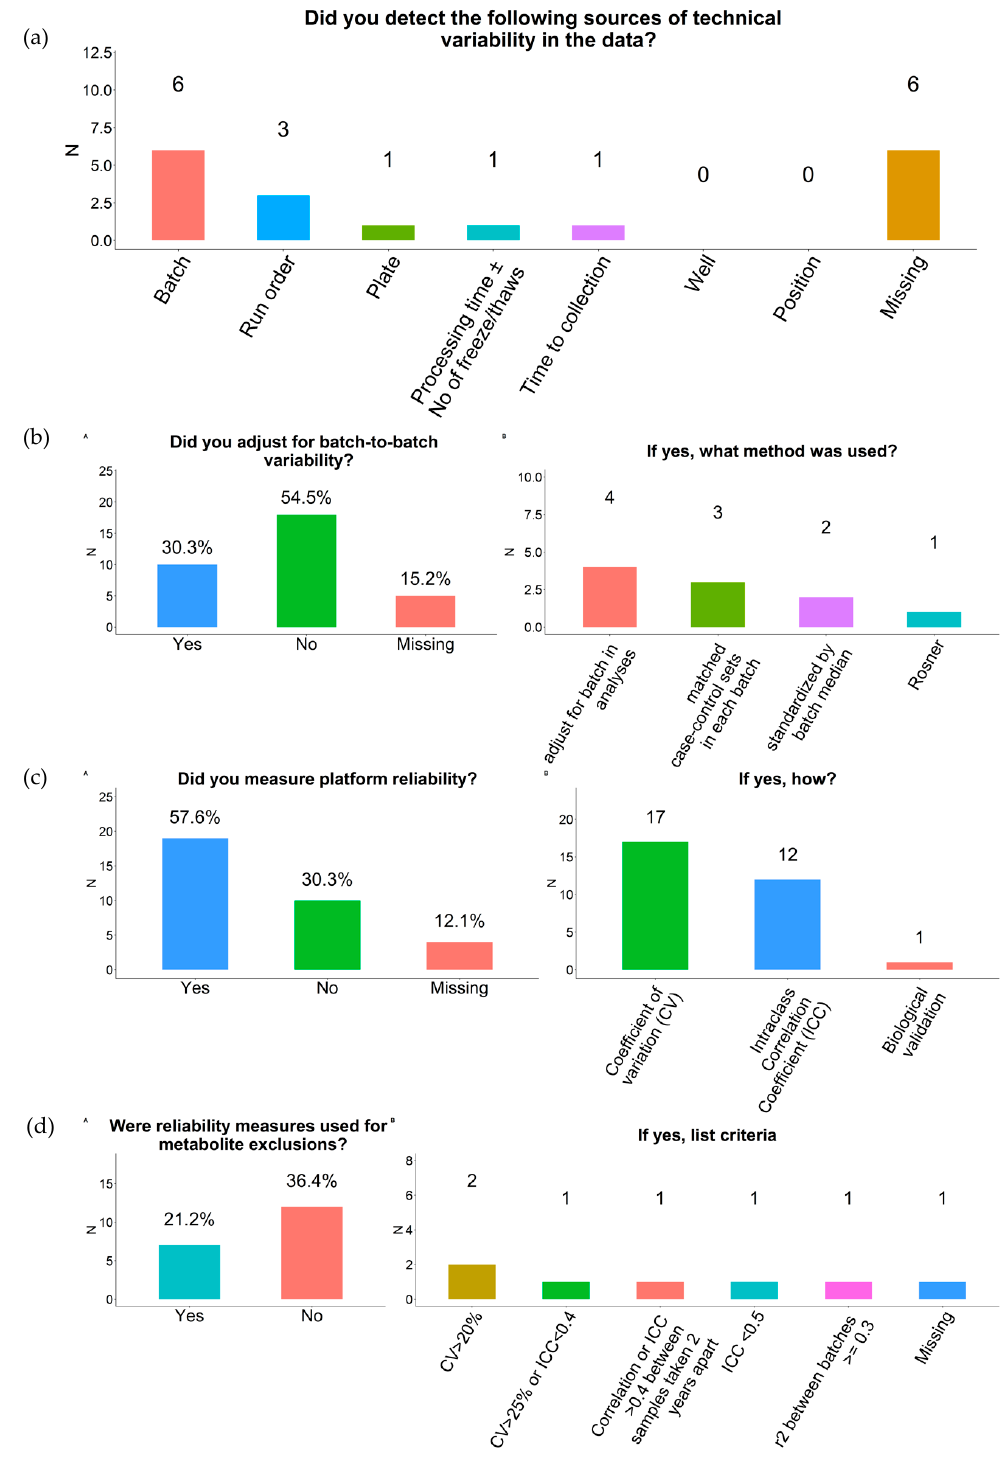
Figure 2. Reliability measures among participating COMETS cohorts. ( a ) Sources of technical variability; ( b ) Batch-to-batch variability; ( c ) Platform reliability; ( d ) Metabolite exclusion criteria. Missing refers to the proportion of respondents that did not answer the question.